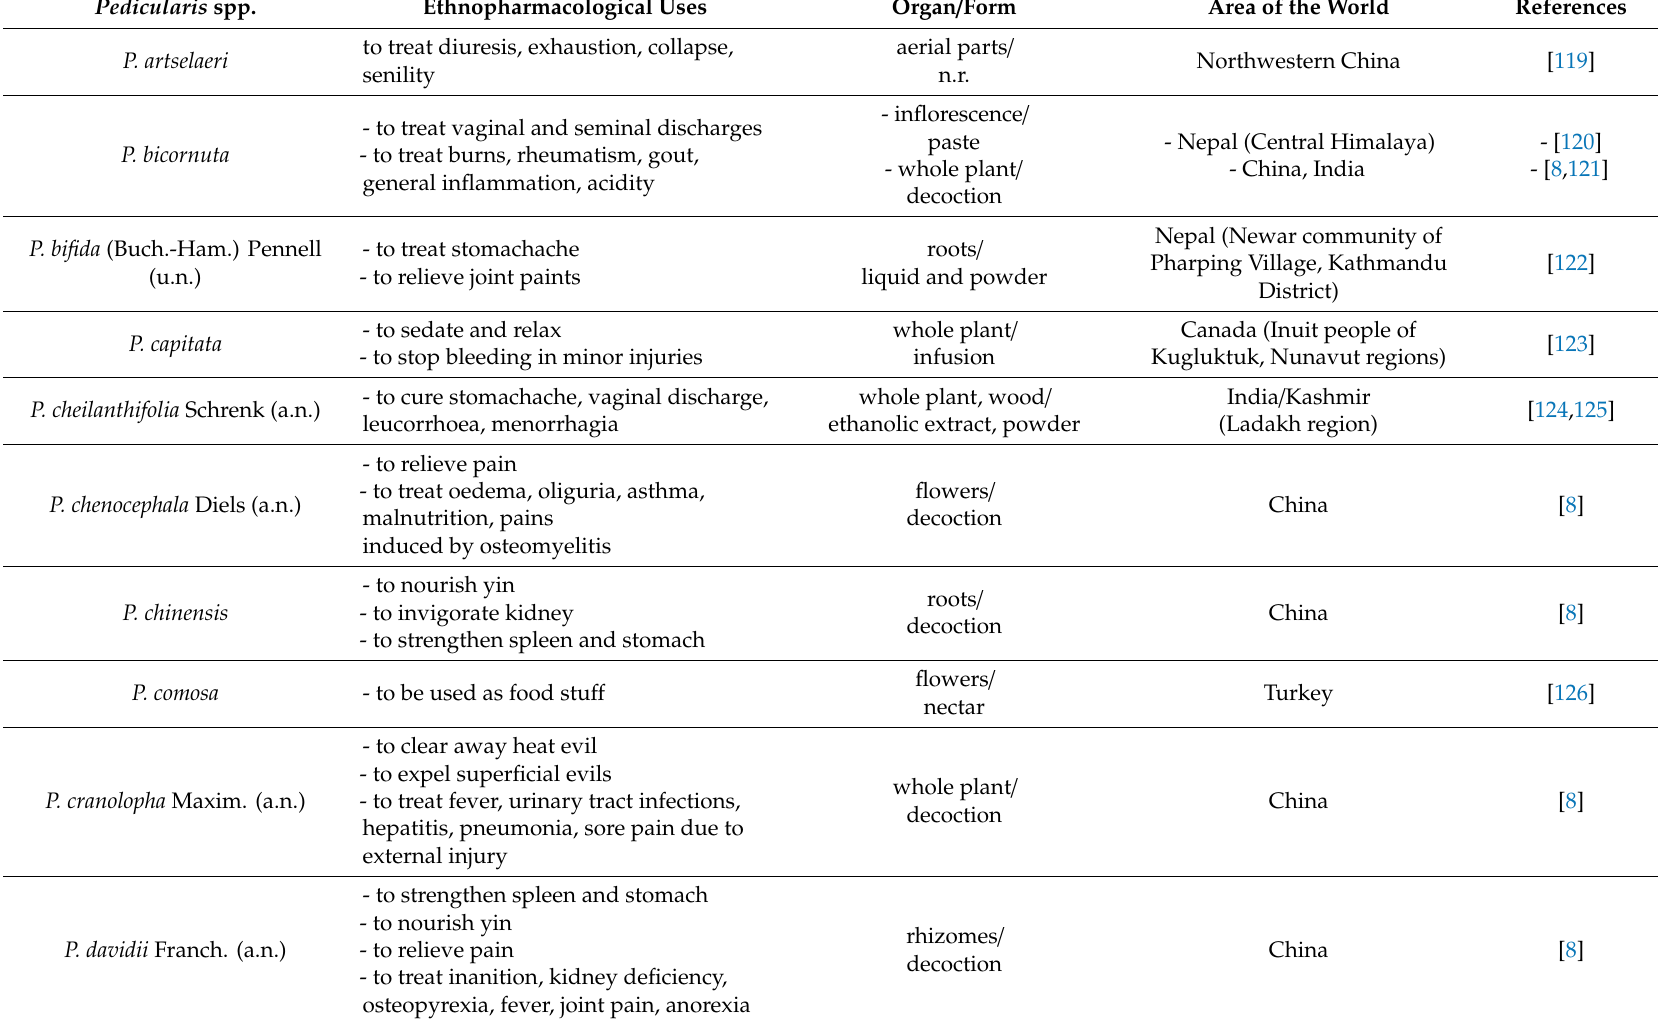
Table 3. Ethnopharmacological Uses of Pedicularis Species as Reported in